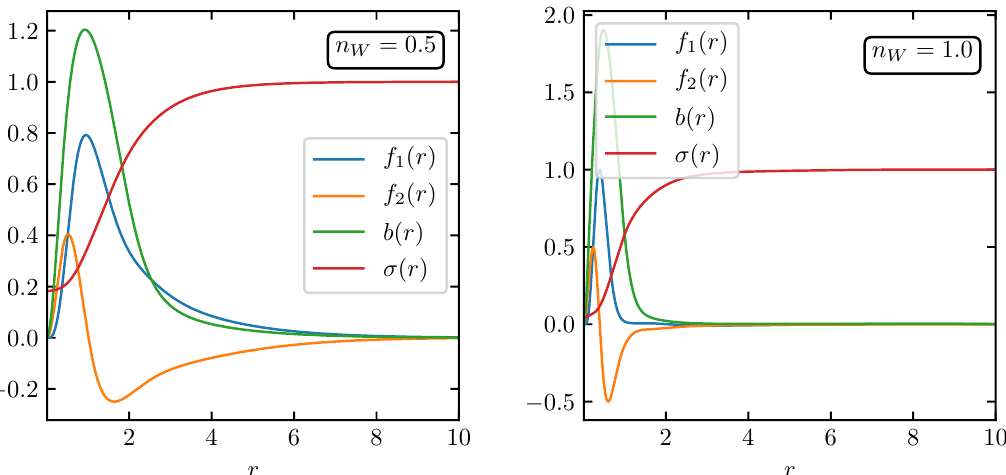
Figure 2 . Field configurations for n W = 1 / 2 and n W = 1 at fixed Λ = 200 GeV as functions of r .